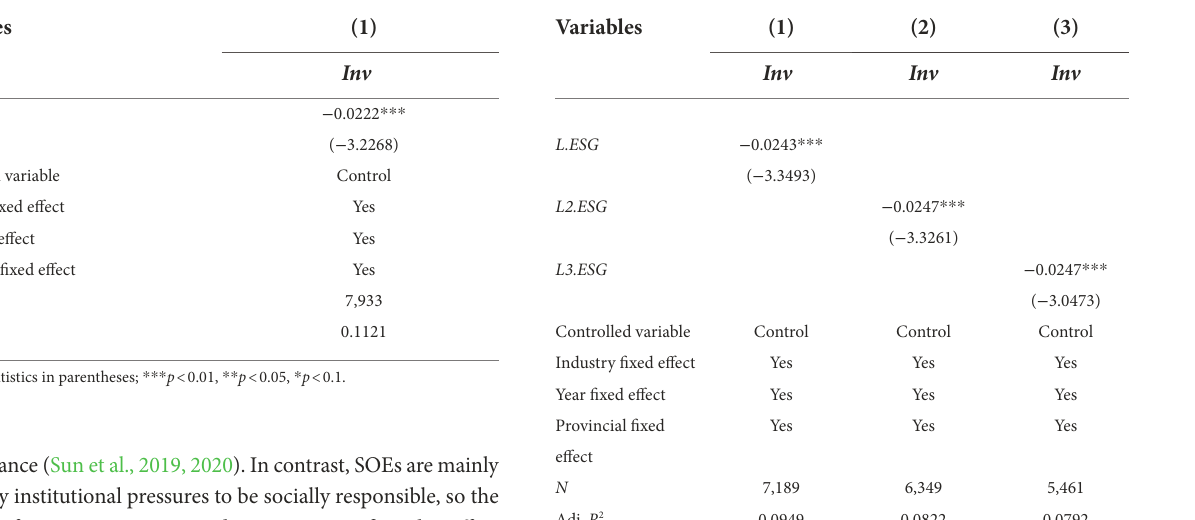
TABLE 9 Endogeneity test with additional control variables. TABLE 10 Endogeneity test with hysteretic